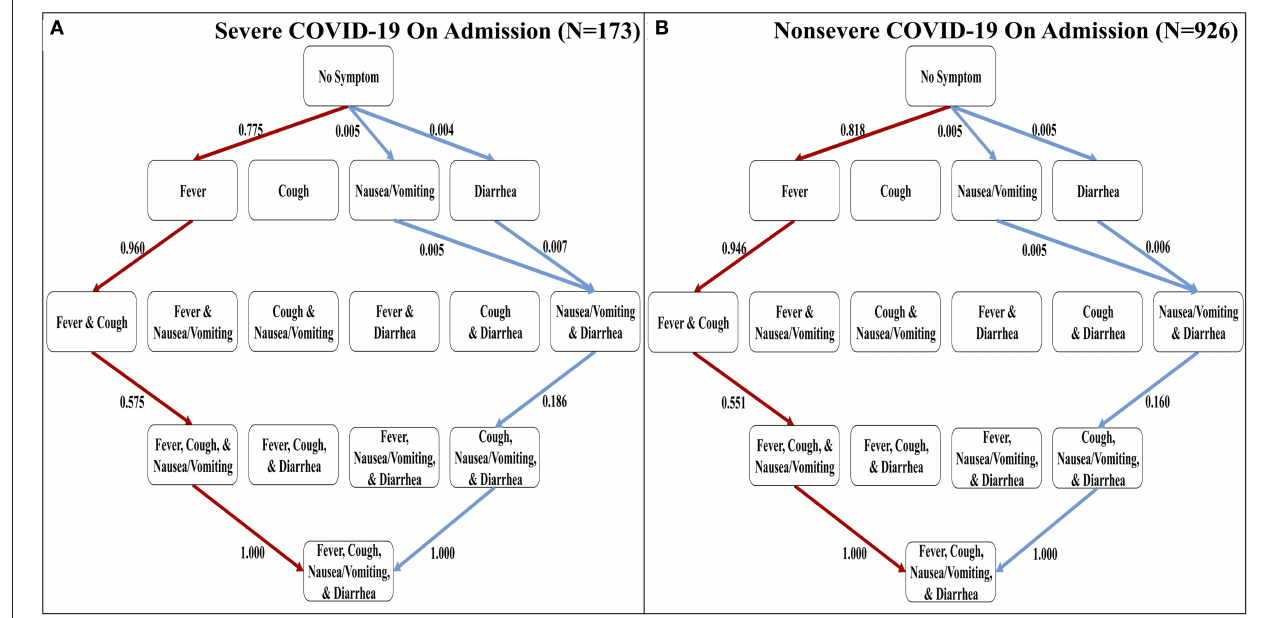
FIGURE 2 | The most and least likely paths of discernible symptoms in severe and non-severe COVID-19 cases on admission. (A) Hasse Diagram of the most likely paths (red) and least likely paths (blue) in COVID-19 for cases designated as severe on admission determined from transition probabilities presented here. (B) Hasse Diagram of the most likely paths (red) and least likely paths (blue) in COVID-19 for cases designated as non-severe on admission determined from transition probabilities presented